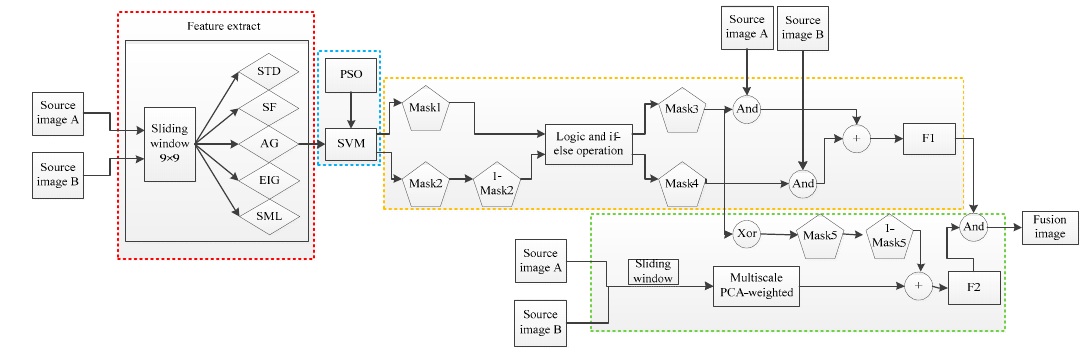
Figure 1. The proposed scheme in this work.